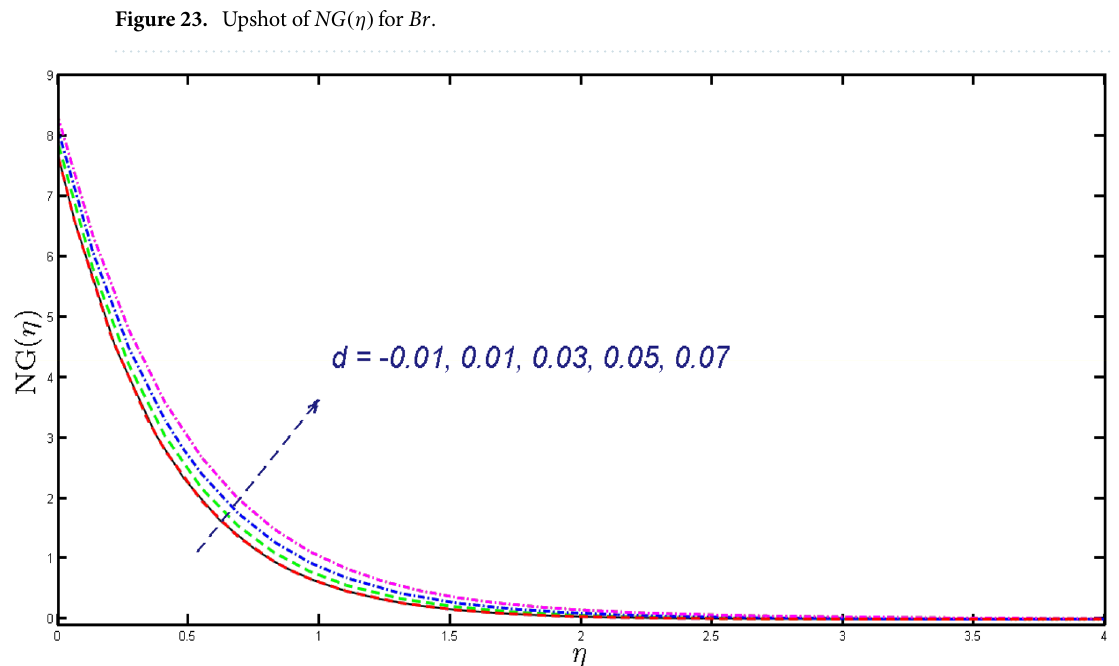
Figure 23. Upshot of NG (η) for Br .